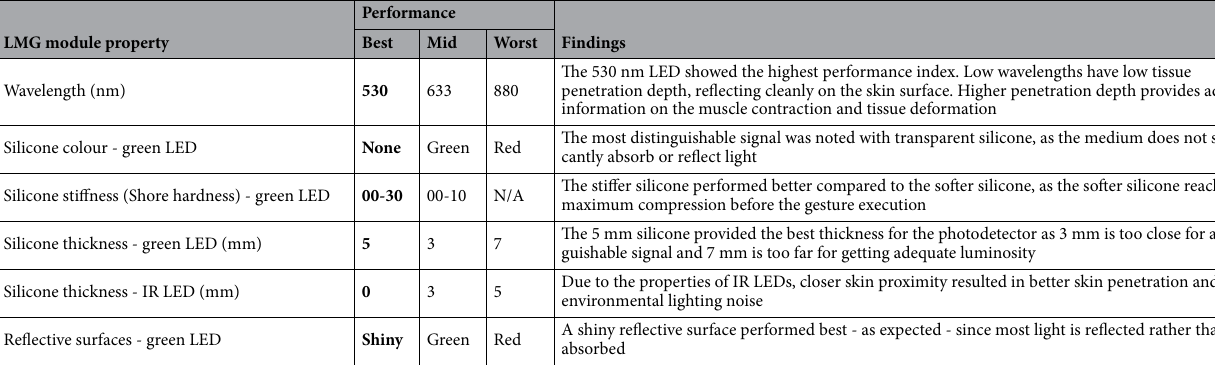
Table 1. Summary of each tested LMG sensing module component, showing the best and worst option for each property. A comprehensive description of the findings is also included. Significant values are in